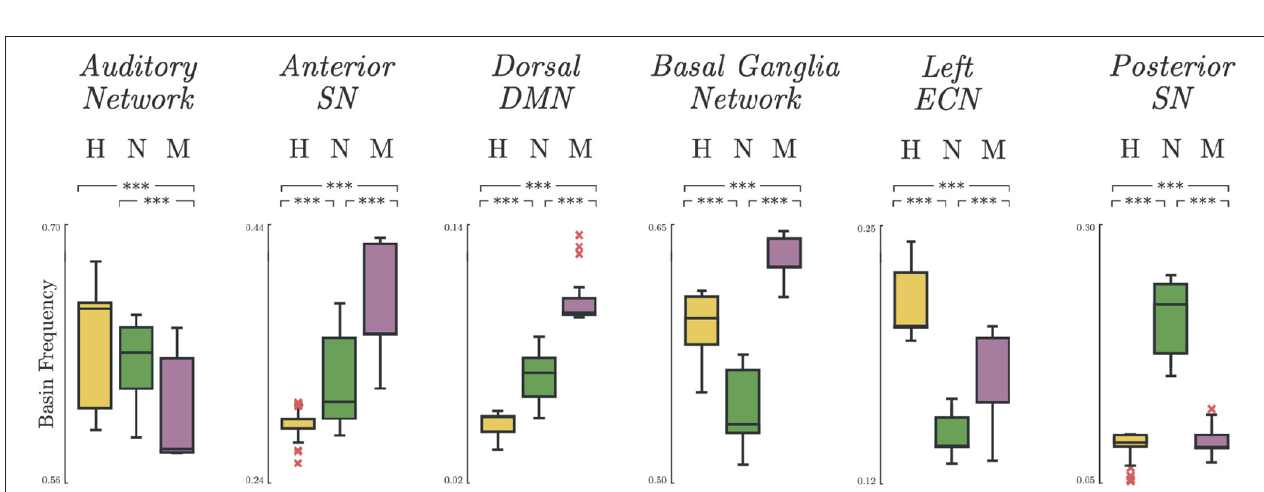
FIGURE 3 | Energy landscapes of healthy, non-melancholic and melancholic groups. Schematic diagram of energy landscapes for Healthy, Non-melancholic, and Melancholic groups on DDMN. States are clustered to the their nearest basin state (Section 2.5). States A1 ( S 279 ) and A2 ( S 232 ) are the common major basins among the groups, while B1 ( S 340 ) and B2 ( S 419 ) are the common minor basins ( Supplementary Table 3 ).